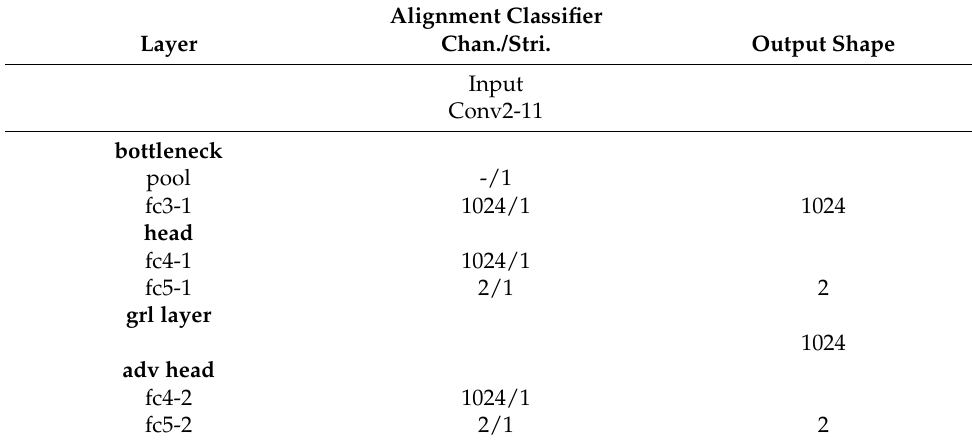
Table 3. Details of alignment